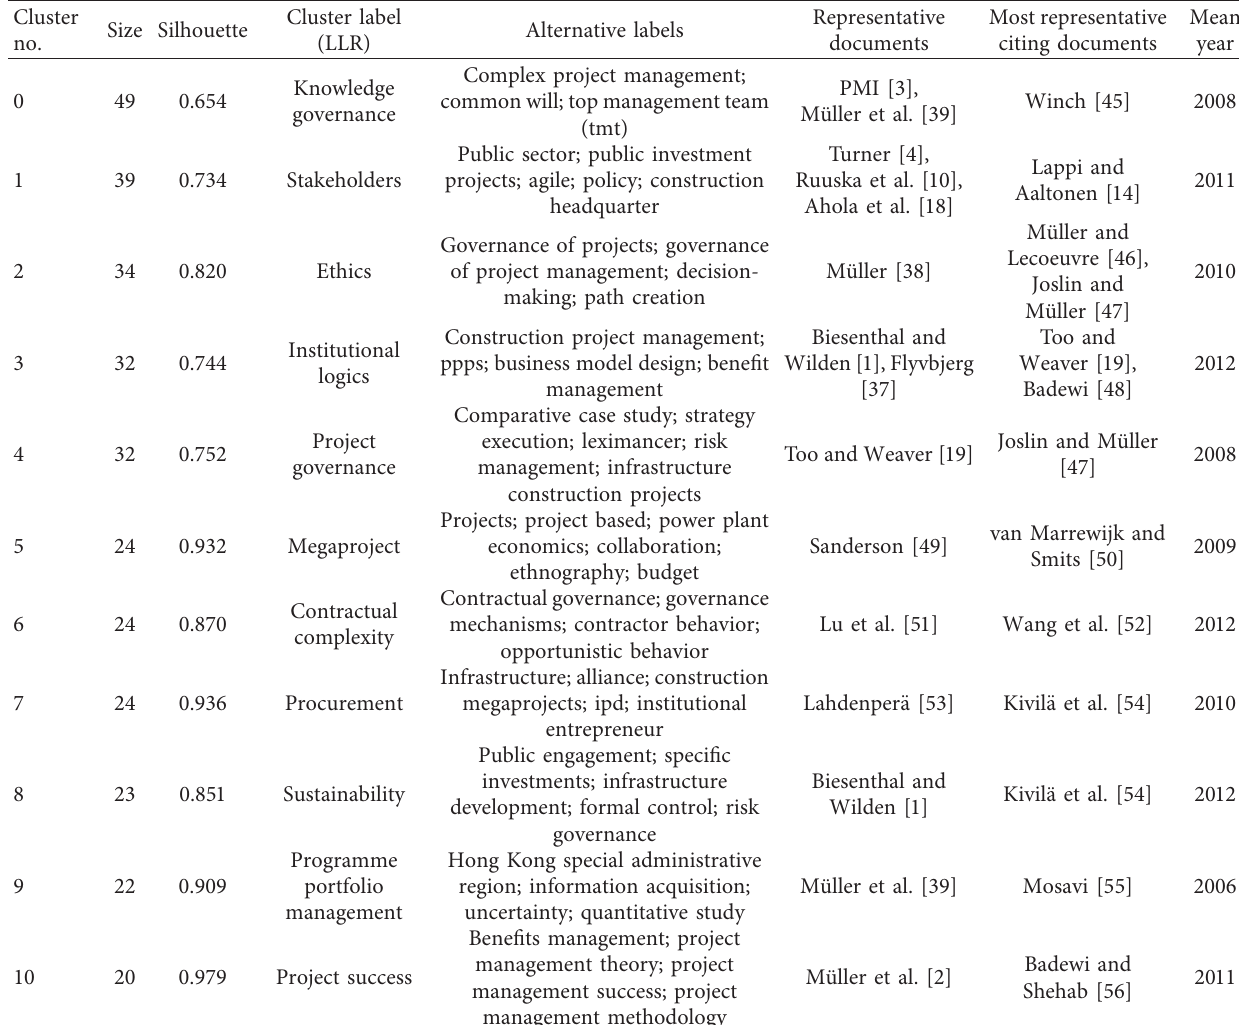
Table 4: Research clusters in the field of project